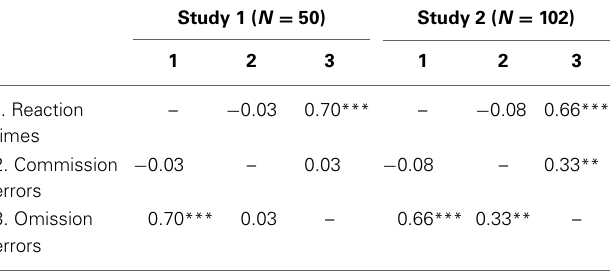
Table 2 | Pearson correlation coefficients between indices of task